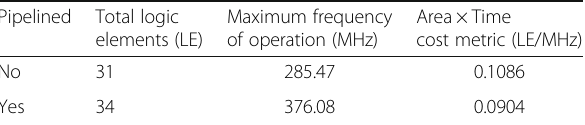
Table 1 Synthesis results of pipelined and non-pipelined implementations of a 45 X multiplier in the Altera Cyclone IV EP4CE115F29C7 FPGA Pipelined Total logic Maximum frequency elements (LE) of operation (MHz)